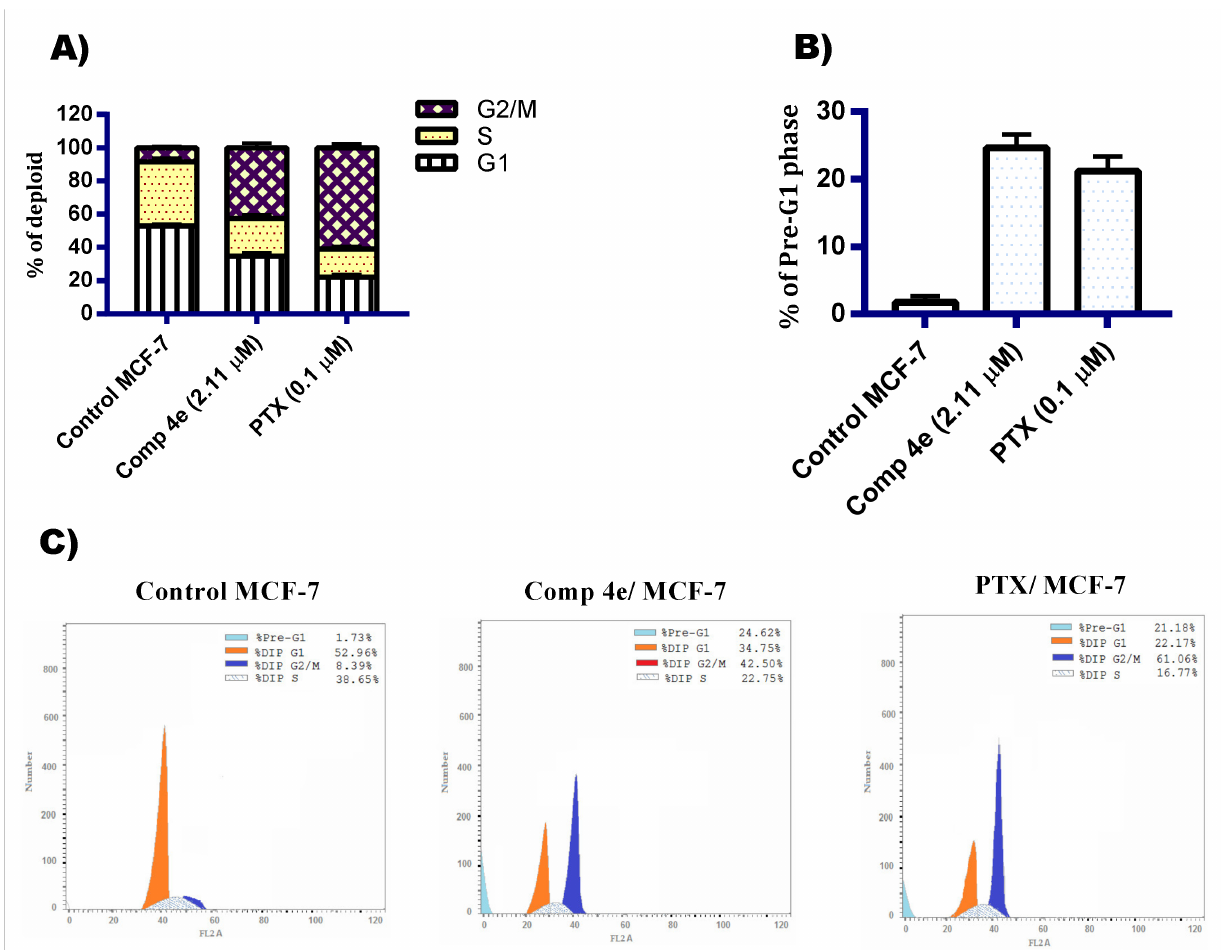
Figure 4. ( A ) Graphical representation of cell cycle analysis of compound 4e and PTX compared with control cells. ( B ) Graphical representation of the percentage of pre-G1 phase after treatment with compound 4e and PTX compared with untreated control cells. ( C ) Effect of compound 4e and PTX on the cell cycle profile compared with untreated control